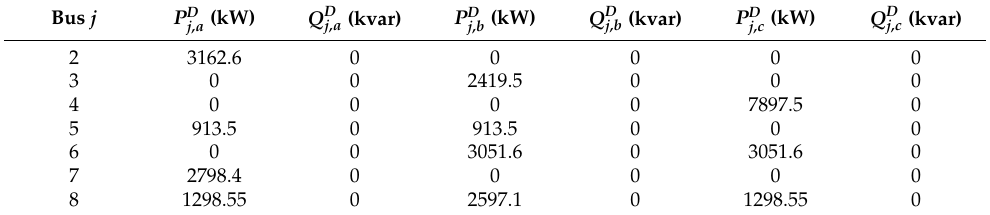
Table 5. Information corresponding to the 8-bus test system for the unbalanced case.